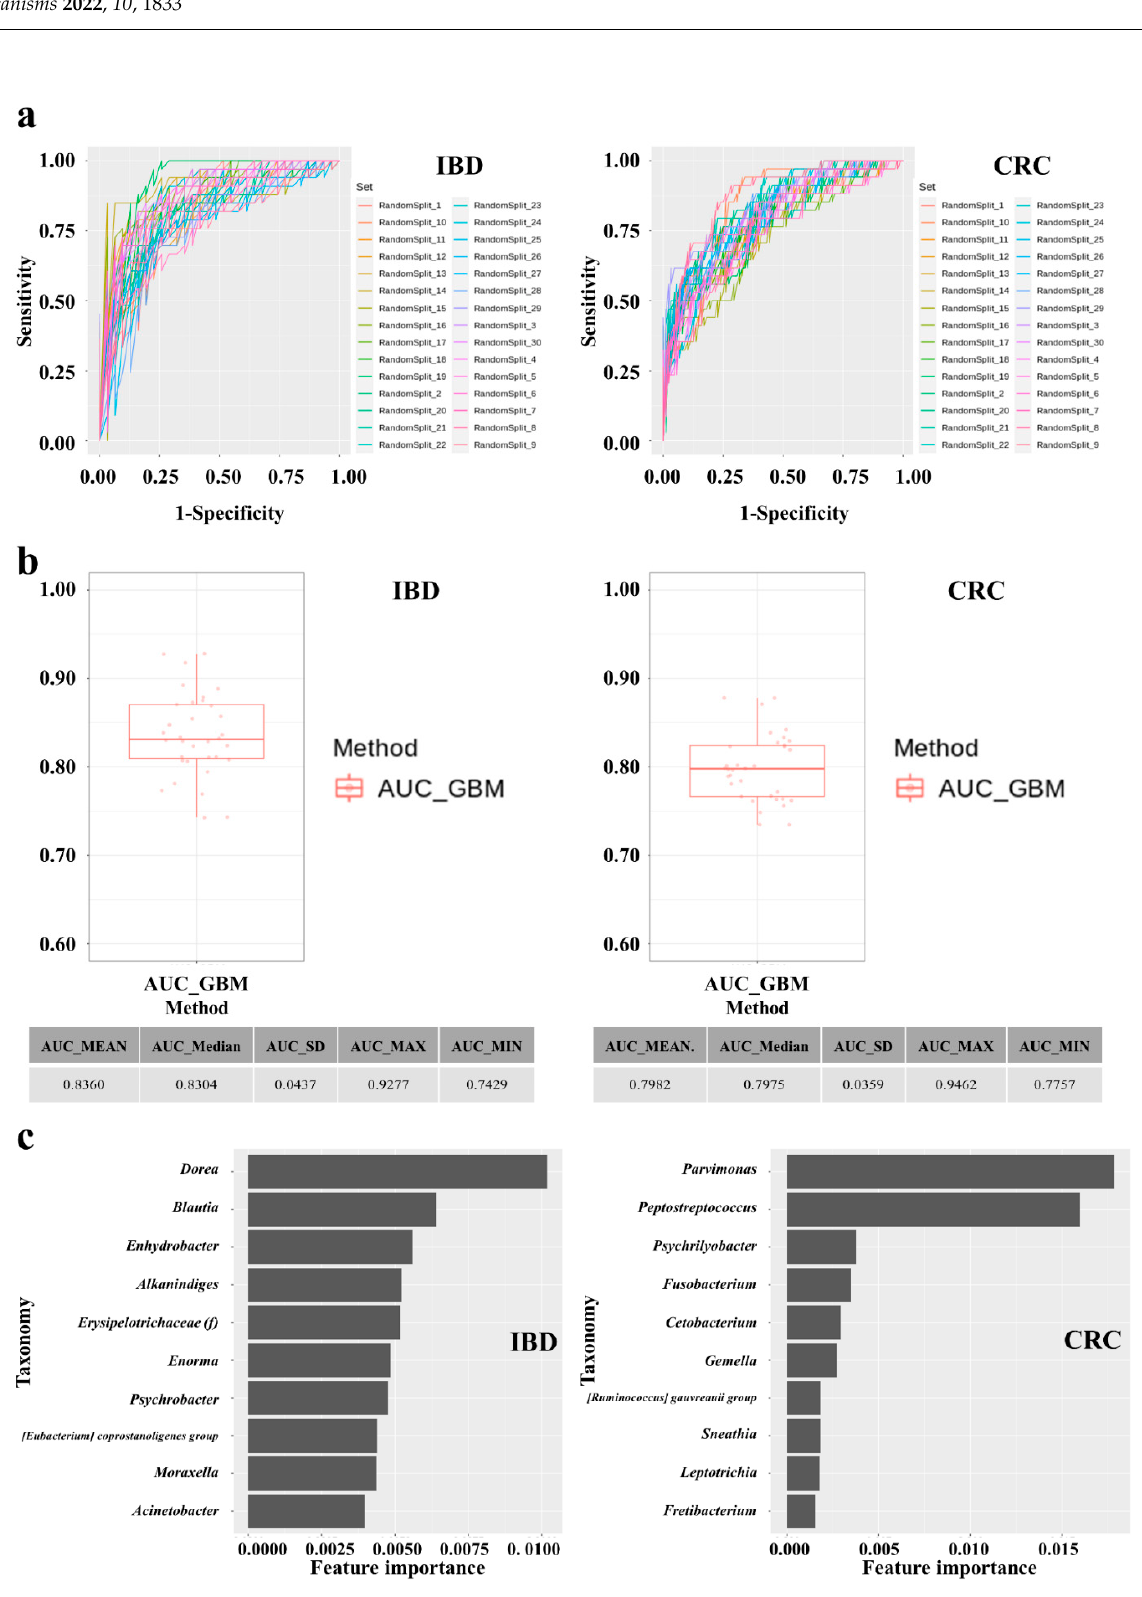
Figure 3. Performance of IBD and CRC risk predictive models. ( a ) ROC curves of 30 iterations of IBD and CRC risk prediction models developed by the GBM machine learning method. ( b ) AUC values for 30 iterations of IBD and CRC risk prediction models developed using the GBM machine learning method visualized in a box plot. ( c ) Feature importance of diagnostic models were assessed based on permutation feature importance analysis of stool microbial taxa.